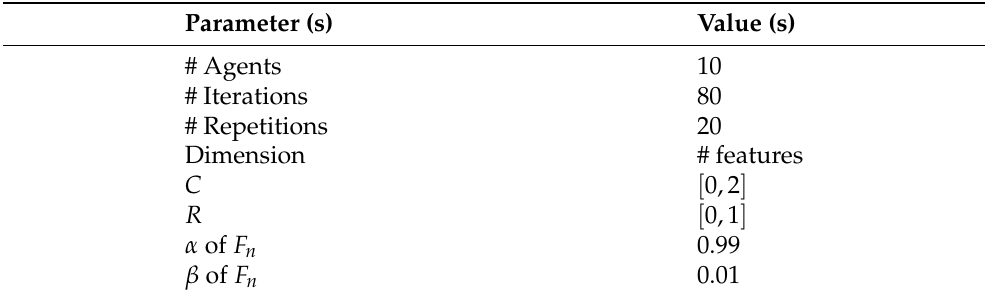
Table 3. Configuration parameters of the GSDTO algorithm.